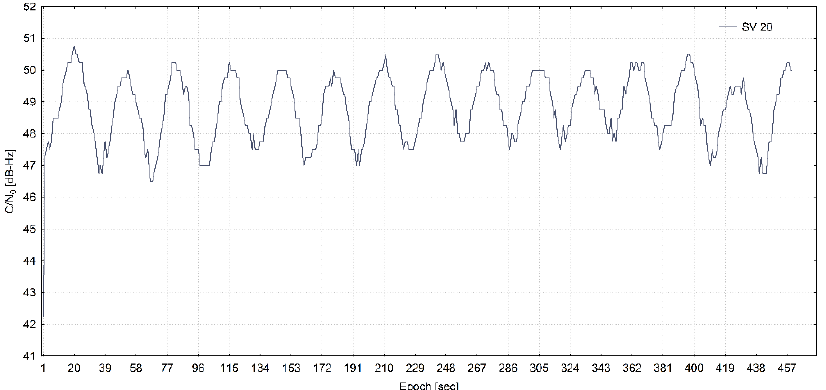
The C/N 0 density ratio for a G20 satellite (SV 20) from a real-world meaconing dataset is shown